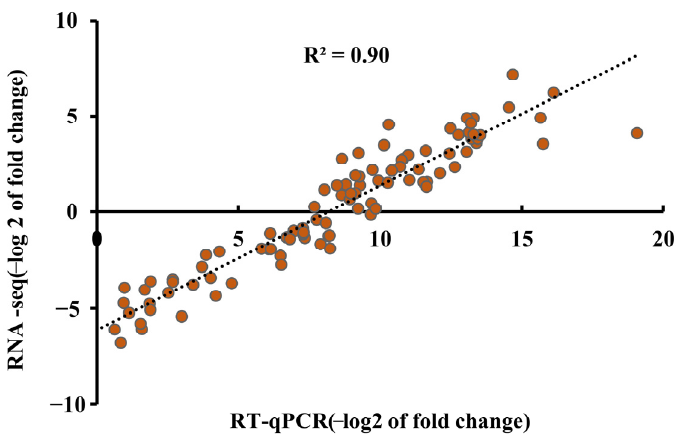
Figure 9. Validation of RNA-seq data by qRT-PCR. Scatter plots represent the transcriptional changes revealed by qRT-PCR analysis and RNA-seq by negative log2 of fold change.